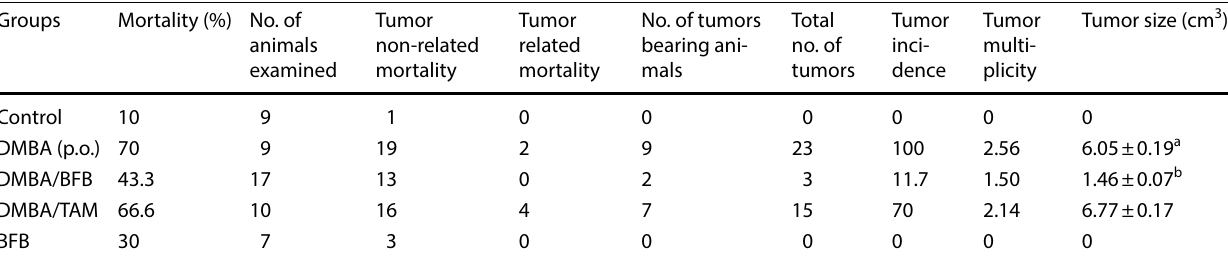
Table 2 Effect of DMBA, TAM, and BFB on the mortality rate, and tumor incidence, multiplicity, count, and size